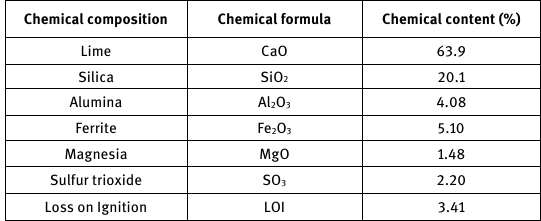
Table 2: The chemical composition of the Gasin Portland Cement Chemical composition